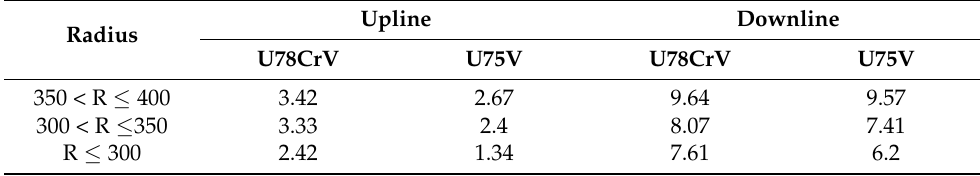
Figure 17. Surface damage situation of a small-radius-curve rail. ( a ) Upper strand; ( b ) Lower strand. Table 20. Statistical results on curved rail life